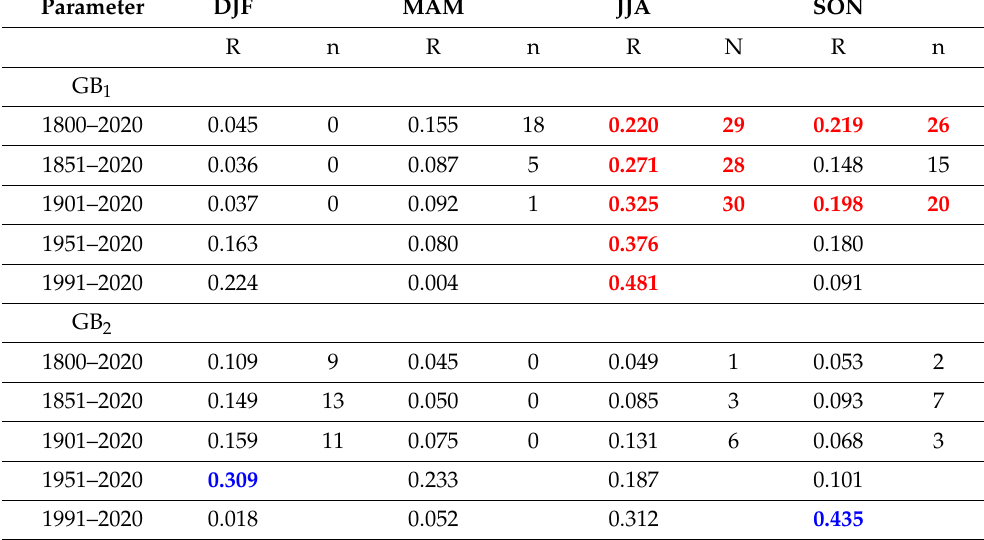
Figure 6. 11-year running standard deviation seasonal series of GB 1 and GB 2 for ( a ) winter (DJF), ( b ) spring (MAM), ( c ) summer (JJA) and ( d ) autumn (SON). Table 1. Mean correlation coefficients (R) and number of ensemble members with significant trends (n), based on individual analysis of all 30 ensemble members of EKF400v2 (1800–1949) spliced with ERA5 (1950–2020), of trends in GBI and NAO for the entire records and various sub-periods. n shows the number of ensemble members with significant trends (for the pre-ERA5 period where ensemble members are used). Significant upward (downward) temporal overall trends, determined based on reference [74], with the corresponding number of significant ensemble trends, are emboldened in red